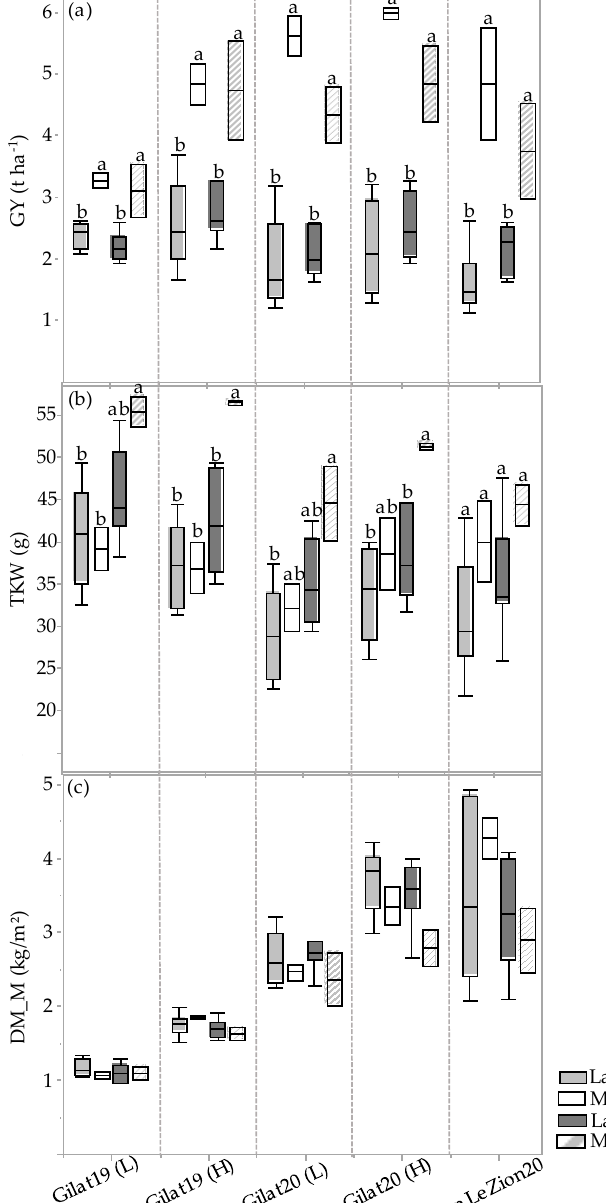
Figure 3. Genotypic groups’ mean comparison under five environments. Grain yield (GY) ( a ), thousand kernel weight (TKW) ( b ), and dry matter accumulation during maturity (DM_M) ( c ). Different letters indicate significant differences between genotypic groups within environments using the Tukey–Kramer test ( p ≤ 0.05).